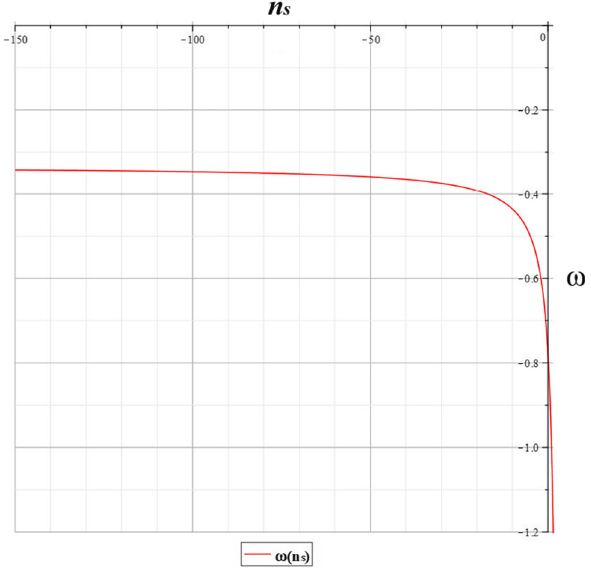
Fig. 2 Plot of the range of ω( n s ) -values for ω < − 1 / 3, in the range where the universe describes an accelerated expansion